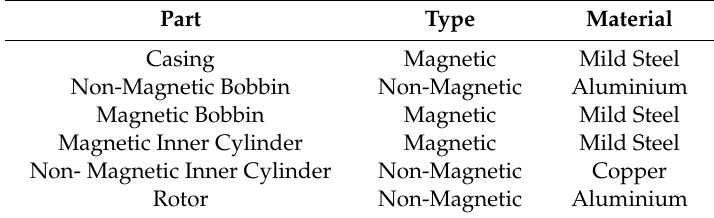
Table 2. List of parts for the proposed rotary MR damper.